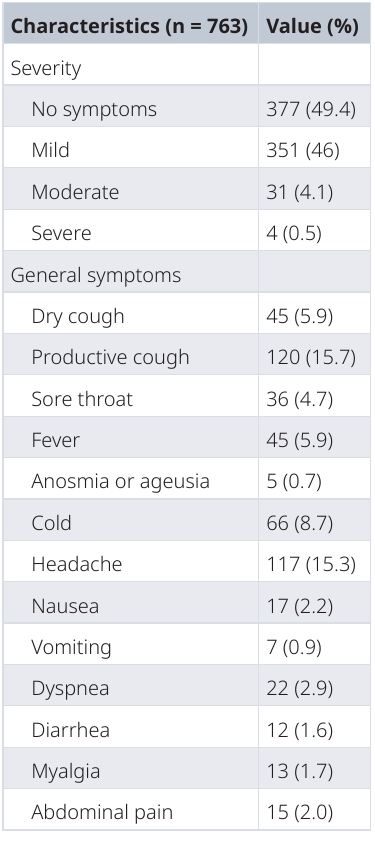
Table 2. Clinical characteristics of patients at COVID-19 Emergency Field Hospital of Bangkalan.